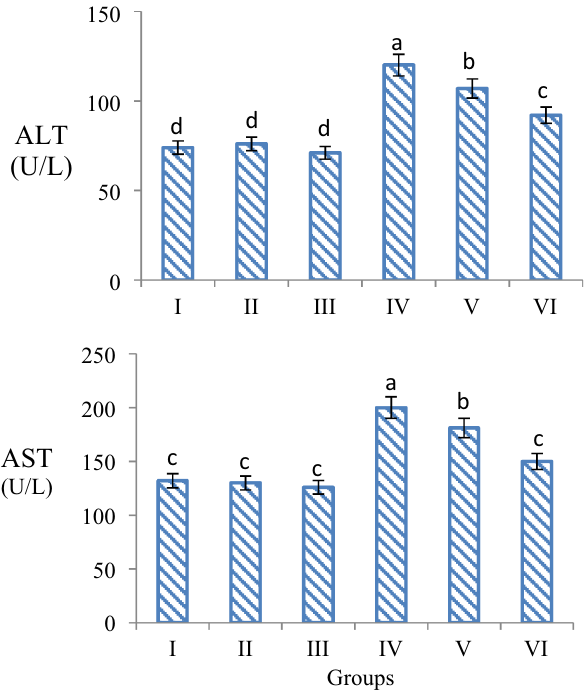
Figure 4. Effects of AFM 2 and quercetin on serum ALT and AST levels. Group I: control, Group II: 25 mg/ kg b.w quercetin, Group III: 50 mg/kg b.w quercetin, Group IV: 16 mg/kg b.w AFM 2 , Group V: 16 mg/kg